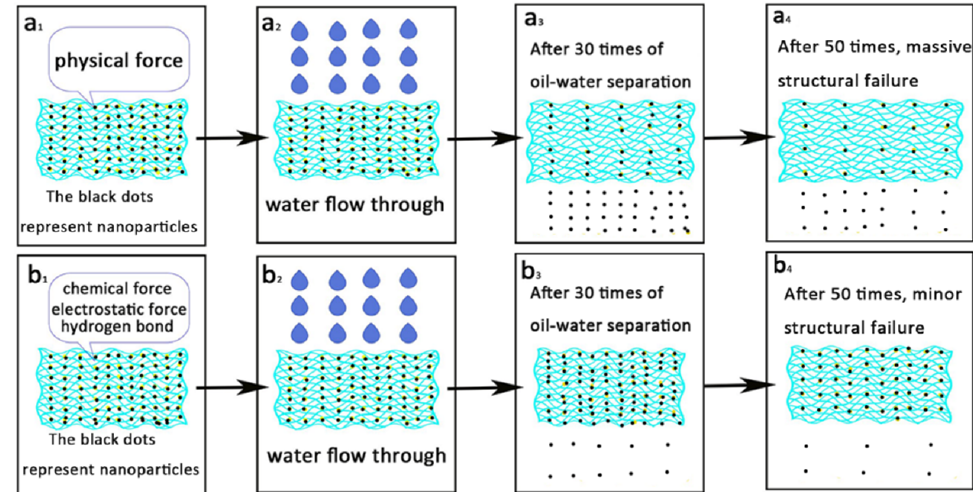
Figure 9. ( a 1–4 ) illustration of the ordinary oil–water membrane separation process, and ( b 1–4 ) illustrate separation using the superhydrophilic-underwater superoleophobic membrane as reported in this article.